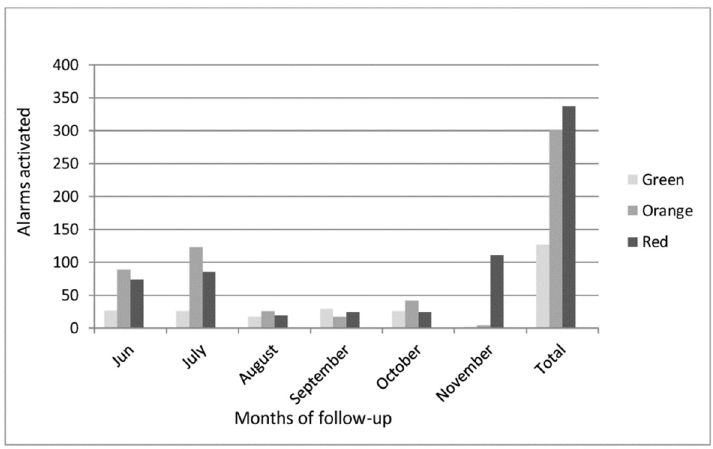
Figure 3. Total number of alerts sent by workers to the COVIDApp healthcare team between 1